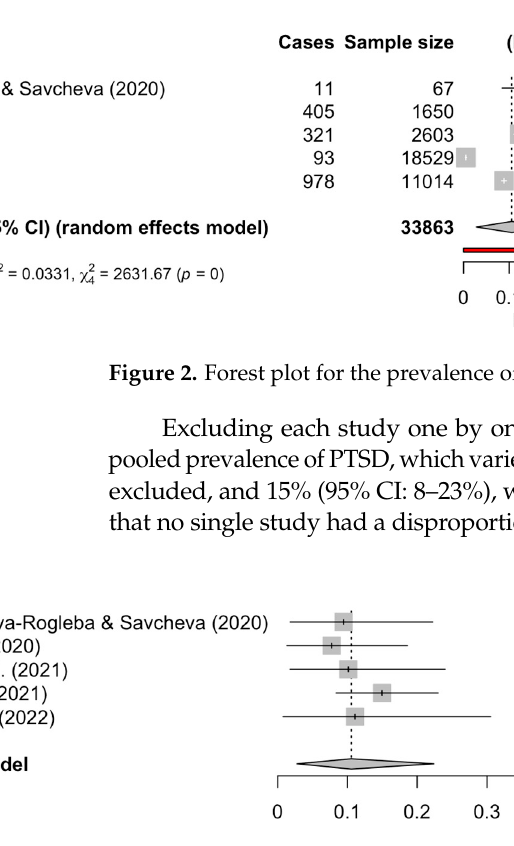
Figure 3. Sensitivity forest plot for the prevalence of PTSD among teachers [11,25,46–48]. A publication bias was indicated by a fail-safe N equal to 427, suggesting that 427 studies with the null result are necessary to reduce the observed overall prevalence to non-significance. This would indicate the absence of publication bias.